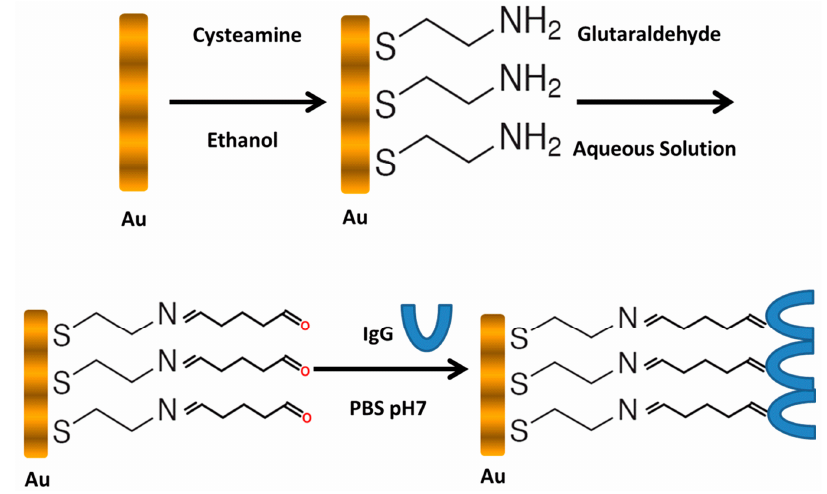
Figure 1. Schematic diagram showing the stepwise modification of gold electrode with cysteamine, glutaraldehyde and polyclonal rabbit Anti-human IgG.